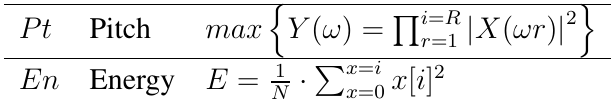
Table 4. Speech features vector d product spectrum) algorithm [44].